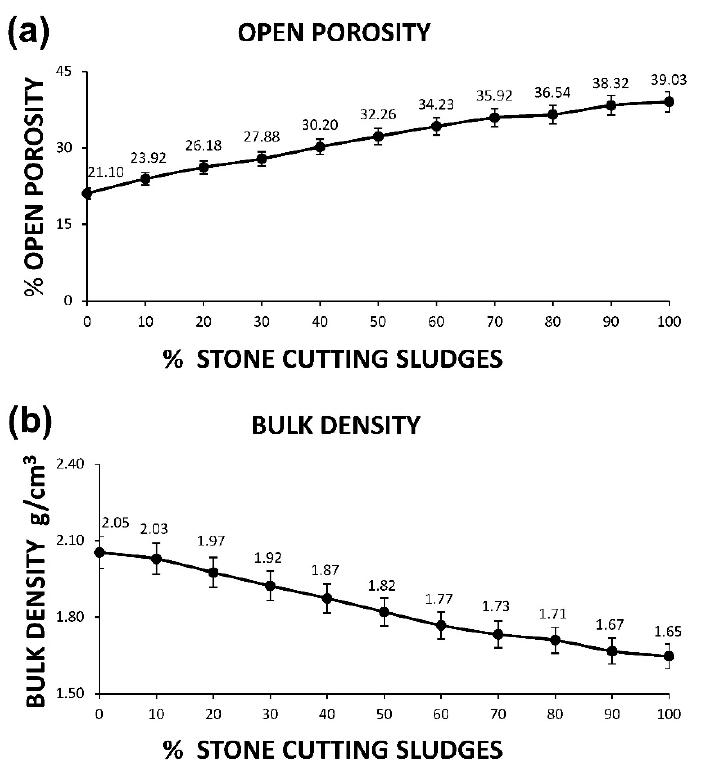
Figure 3. Graphs of the physical tests of the di ff erent groups of ceramic samples as a function of the percentage of stone cutting sludges. ( a ) Open porosity and ( b ) bulk density.